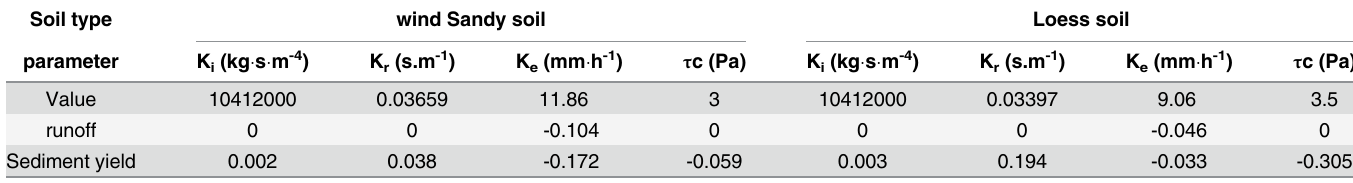
Table 1. The calibrated values and sensitivity ratio of soil parameters based on the WEPP plot